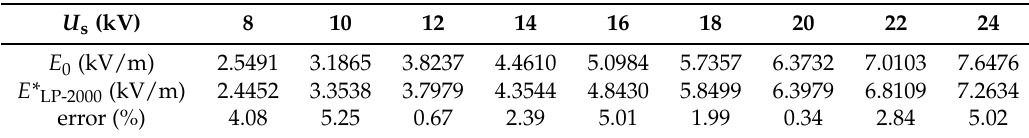
Table 7. Corrected data statistics with different excitation voltages (in the case of an approaching human